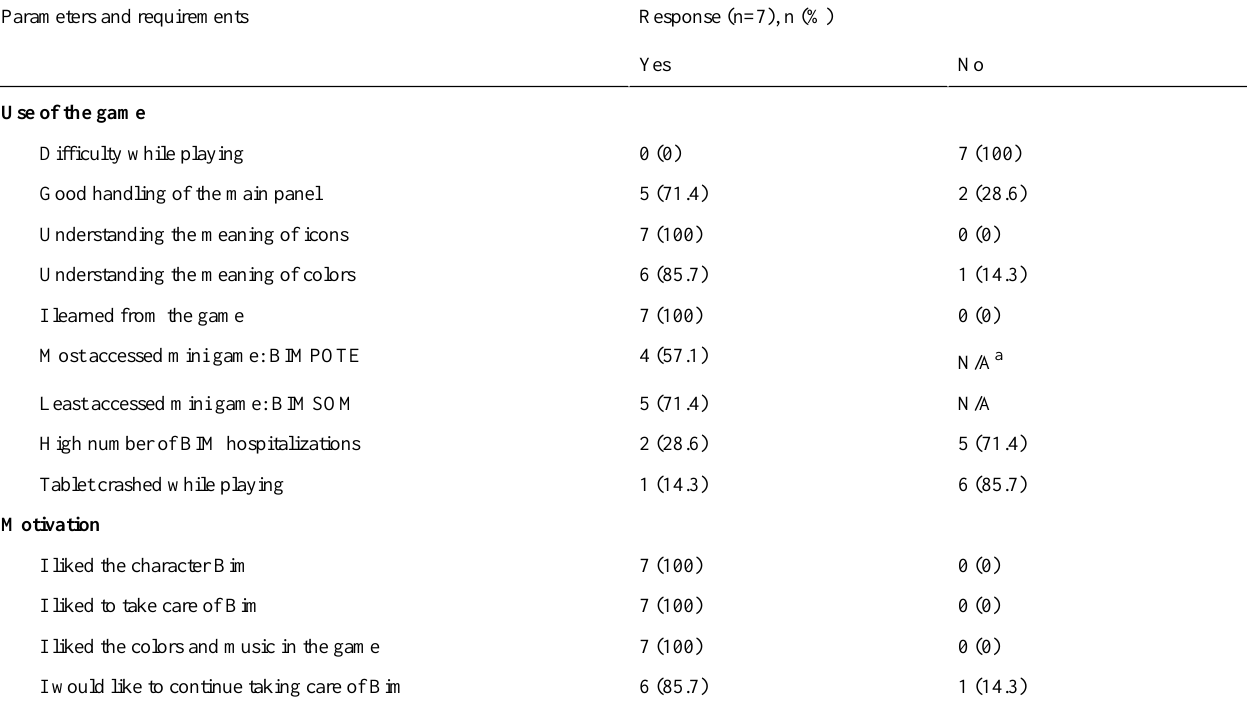
Table 1. Evaluation of the use and motivation to handle the Bim app.